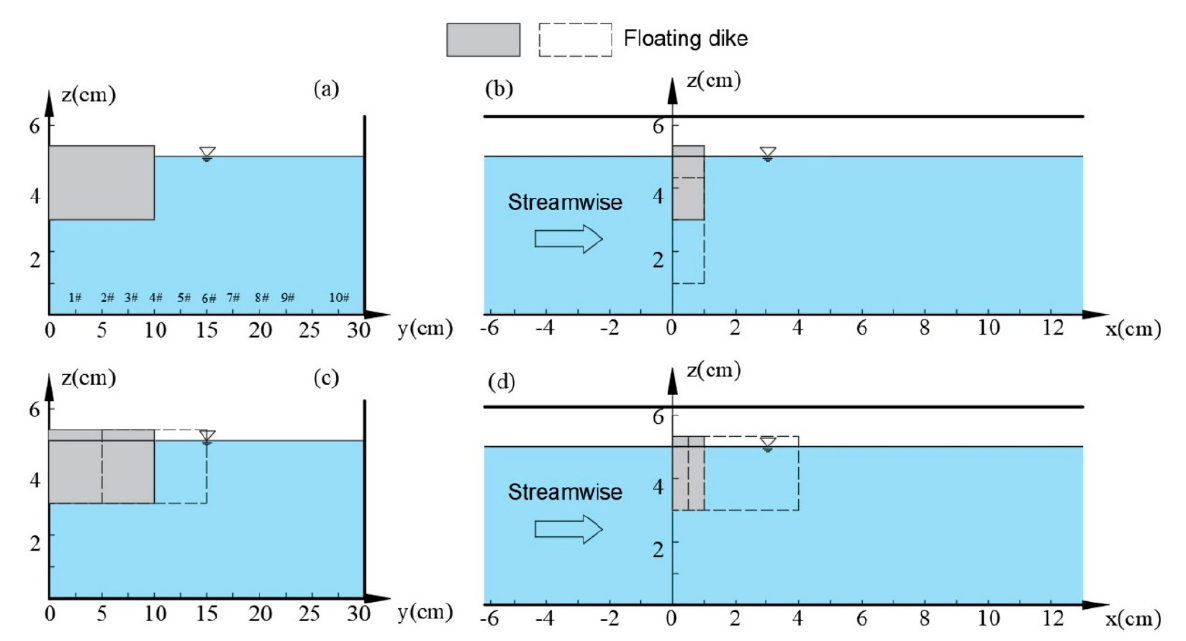
Figure 3. Experimental setup of ( a ) the measured longitudinal sections 1# to 10#; the floating dikes with different ( b ) submerged depths, ( c ) lengths, and ( d ) thicknesses.